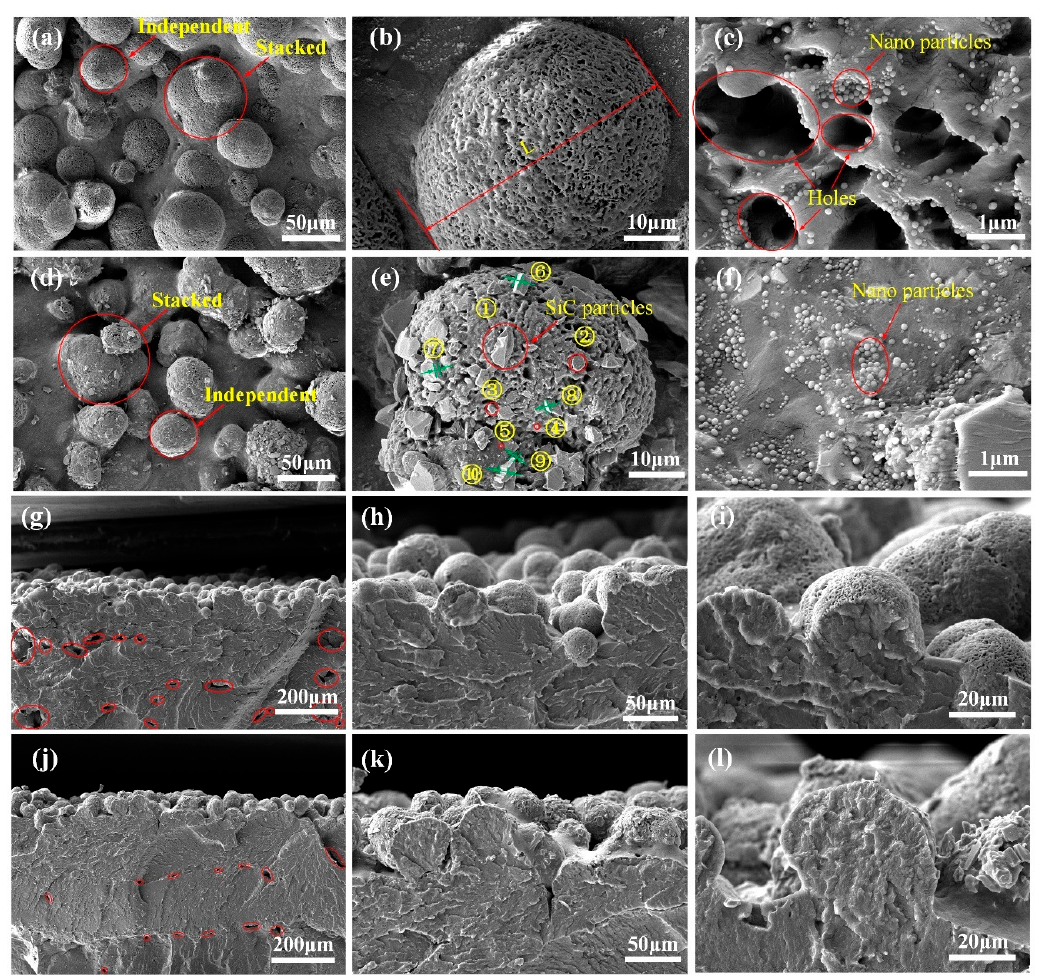
Figure 2. SEM images of the printed specimens. ( a – c ) are the surface images of the pure PA12 at magnifications of 1000, 5000, and 50000, respectively. ( d – f ) are the surface images of the SiC/PA12 composites at magnifications of 1000, 5000, and 50000, respectively. ( g – i ) are the cross-section im- ages of the pure PA12 composites at magnifications of 300, 1000, and 3000, respectively. ( j – l ) are the cross-section images of the SiC/PA12 composites at magnifications of 300, 1000, and 3000, respec- tively.